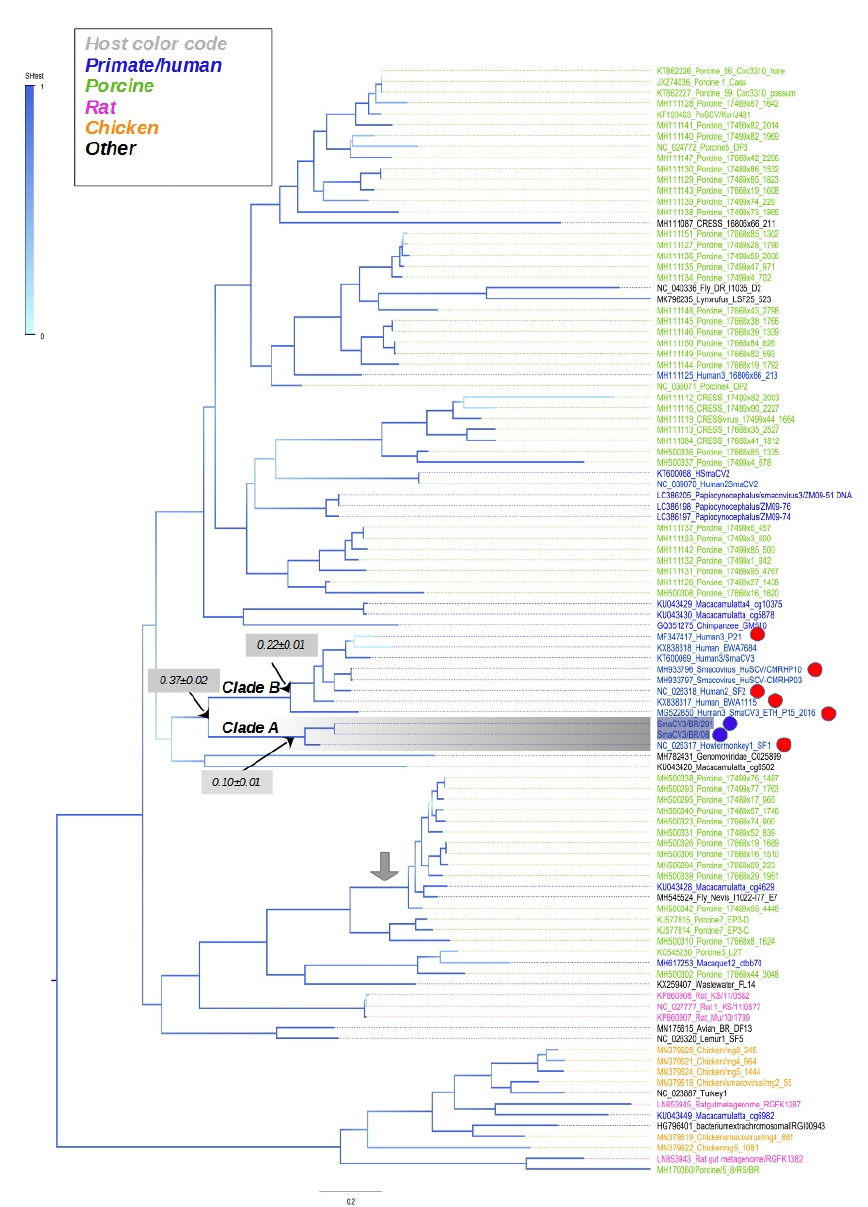
Figure 3. Phylogenetic analysis of complete genomes of smacoviruses. Maximum likelihood tree inferred assuming the GTR model. The tree is mid-rooted, and the statistical branch support (based on the Shimodaira–Hasegawa test) is indicated in a blue color scale. Lower horizontal bar indicates the nucleotide substitutions per site. Porprismacoviruses identified in this study are indicated by blue dots. Red dots indicate sequences used for nucleotide identity (Table 1 in the main text). The genetic divergence of some clades is indicated in the gray rectangles. Sequences are colored according to their hosts (upper left panel).